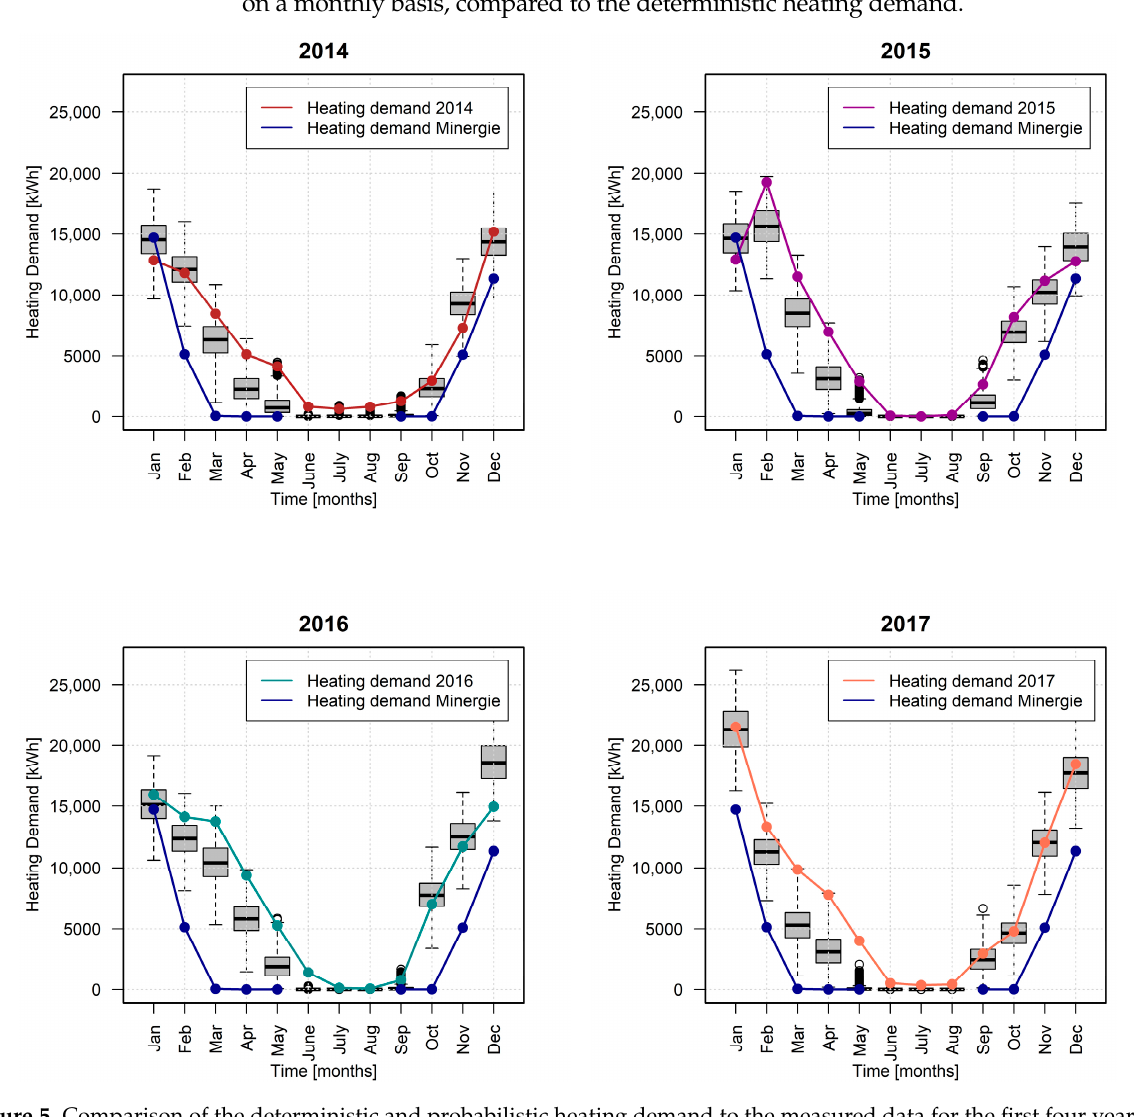
Figure 5. Comparison of the deterministic and probabilistic heating demand to the measured data for the first four years of building operation.